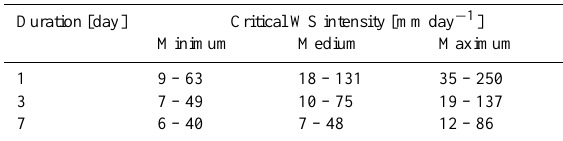
Table 3. Range of critical water supply (WS) intensities calculated from the normalized minimum, medium and maximum ID thresh- old over durations of 1, 3 and 7 days. Different threshold intensities result from spatial variation of the precipitation day normal (PDN) (see Fig.